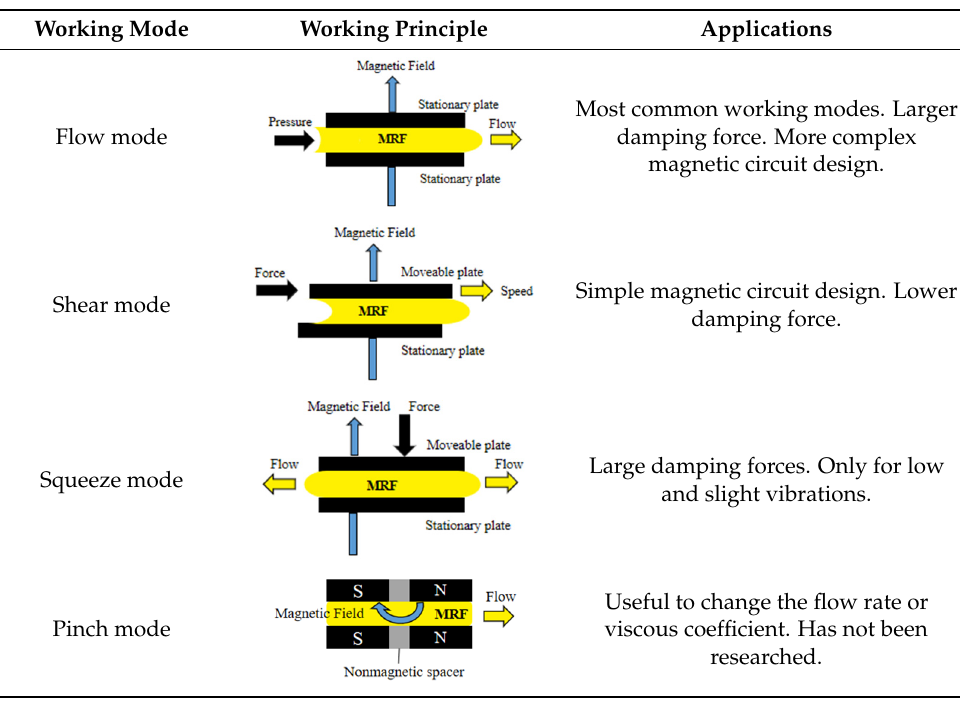
Table 1. MRF working modes.